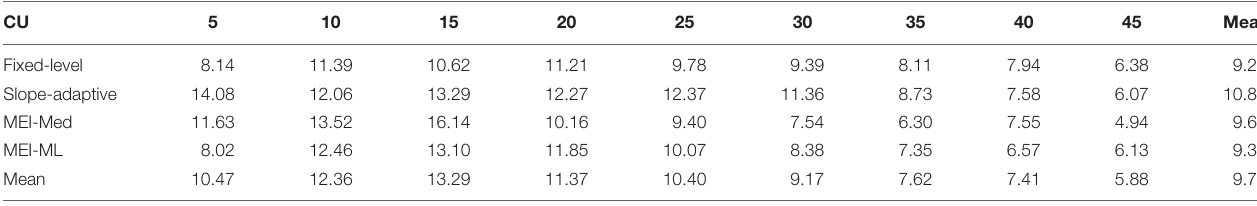
Values are given in dB. TABLE 2 | Standard deviations of sound pressure level (SPL) for each categorical unit (CU) for participants with normal hearing for each of the four CLS procedures at 4 kHz.